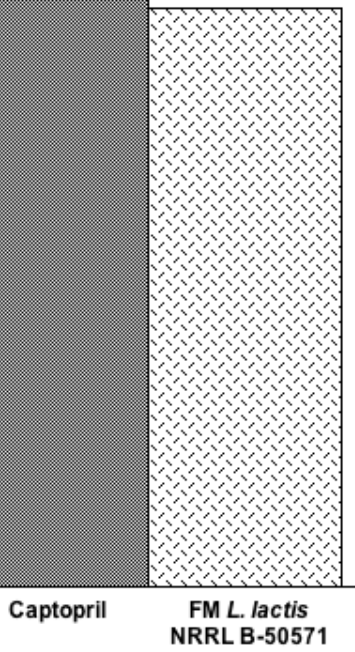
Figure 7. Superoxide dismutase (U/mL) in plasma from spontaneously hypertensive rats after long-term treatments. Negative control: purified water; Captopril: 40 mg/kg body weight; FM L. lactis NRRL B-50571 (ad libitum): fermented milk with Lactococcus lactis NRRL B-50571. Data are presented as median; and were analyzed by non-parametric test (Kruskal–Wallis p < 0.05).